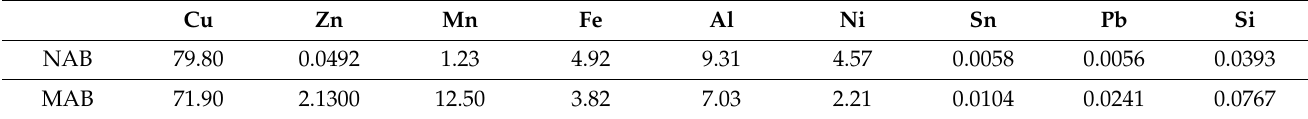
Table 1. Chemical composition of NAB and MAB (wt.%) as provided by the